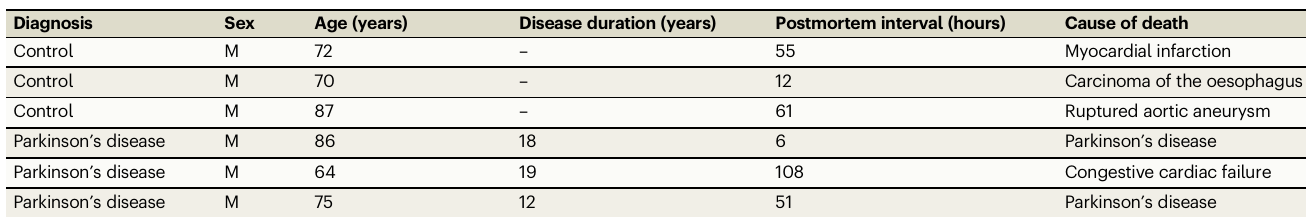
Table 1 | Brain donor demographic information Diagnosis Disease duration (years) Control Control Control M 87 – Parkinson ’ s disease Parkinson ’ s